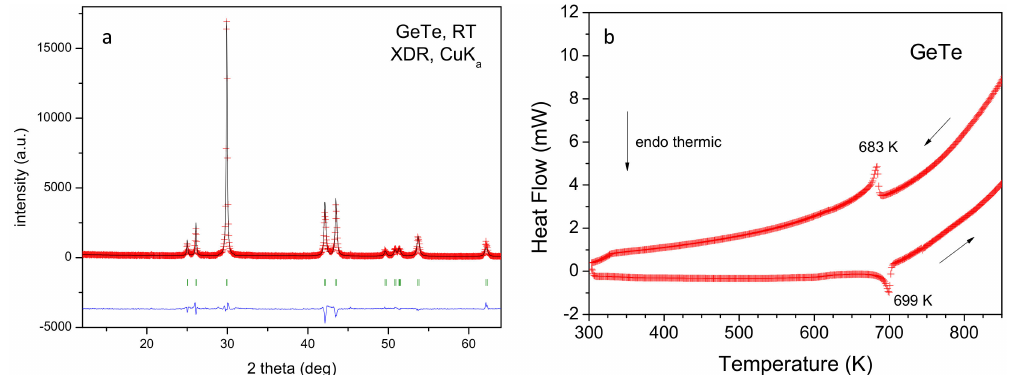
Figure 1. ( a ) XRD pattern of GeTe from laboratory XRD, displaying the characteristic splitting of the rhombohedral phase at RT; ( b ) Di ff erential scanning calorimetry (DSC) curves, showing an endothermic peak in the heating run, and an exothermic peak in the cooling